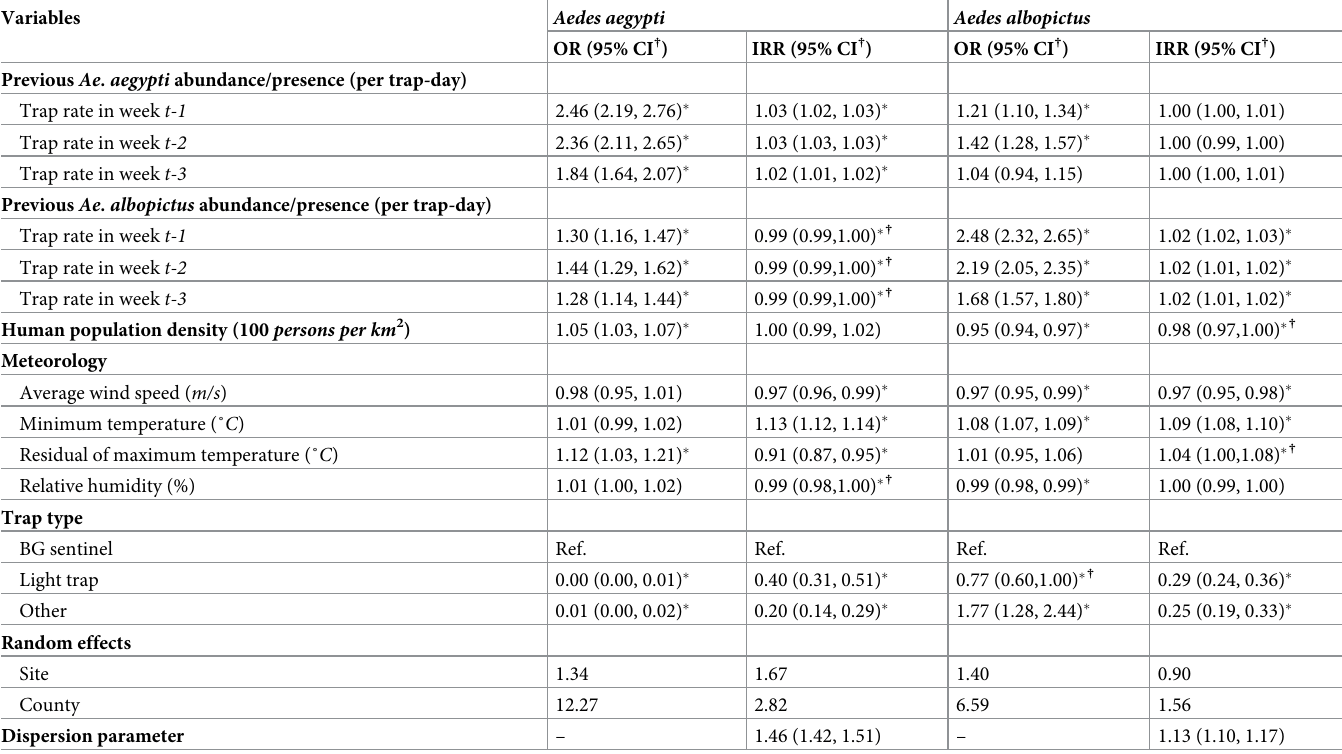
Table 2. Estimates of odds ratio (OR) and incidence rate ratio (IRR) from mixed-effects zero-inflated negative binomial analysis of Aedes aegypti and Aedes albopic- tus in Florida, 2004–2018.